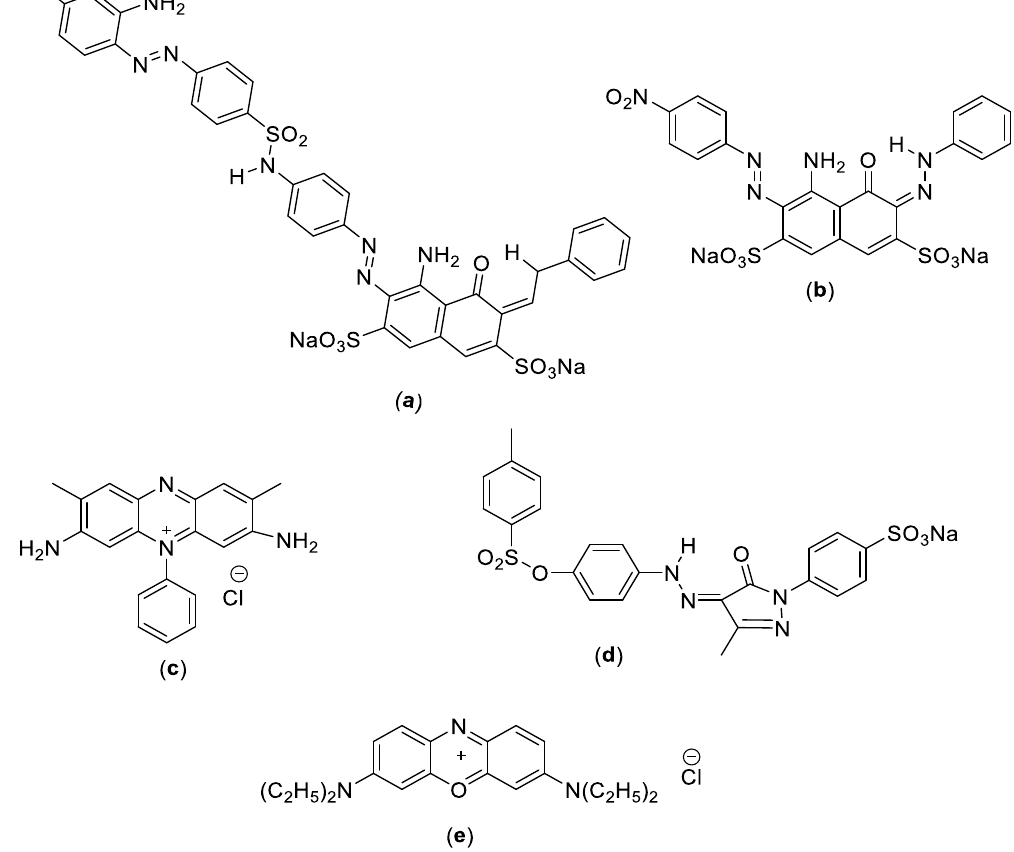
Figure 10. Structure of the different dyes ( a ) acid black-234 (AB234) ( b ) acid black-1 (AB1) ( c ) safranin ( d ) acid yellow-76 (AY76) ( e ) basic blue-3 (BB3).